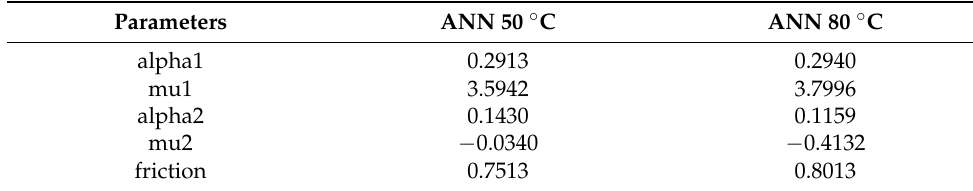
Table 4. ANN predicted Ogden-2 hyperelastic material parameters at 50 ◦ C and 80 ◦ C. Parameters